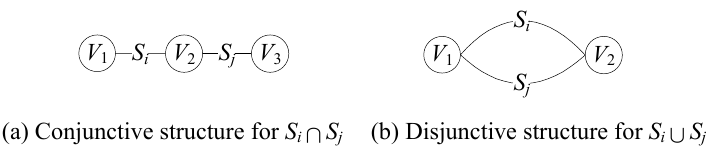
Figure 2. Two basic structures of UIGraph for the set query.